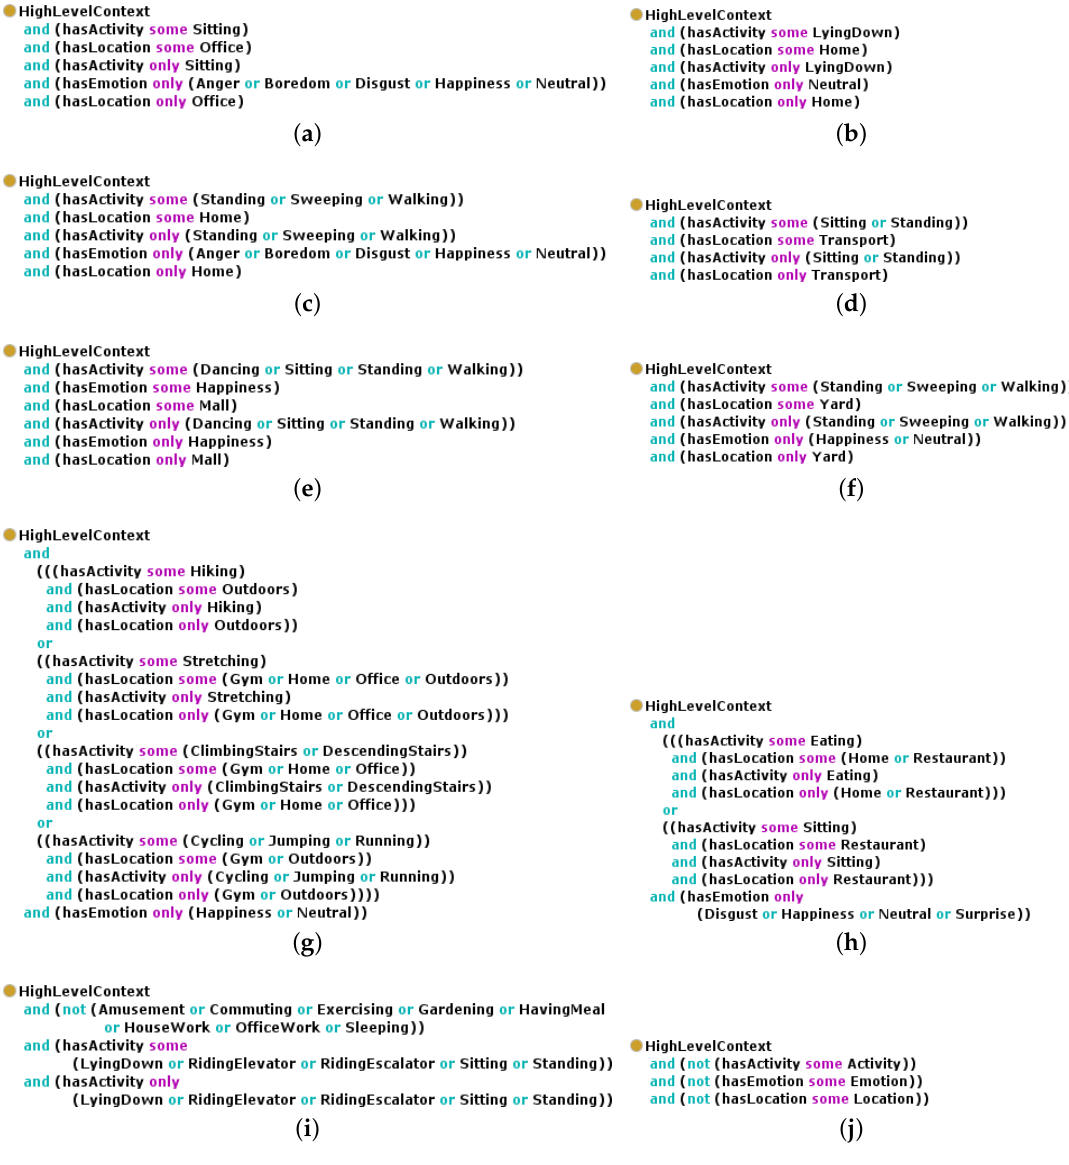
Figure 3. Mining minds context ontology: definition of the ten subclasses of HighLevelContext . ( a ) OfficeWork ; ( b ) Sleeping ; ( c ) HouseWork ; ( d ) Commuting ; ( e ) Amusement ; ( f ) Gardening ; ( g ) Exercising ; ( h ) HavingMeal ; ( i ) Inactivity ; ( j ) NoHLC